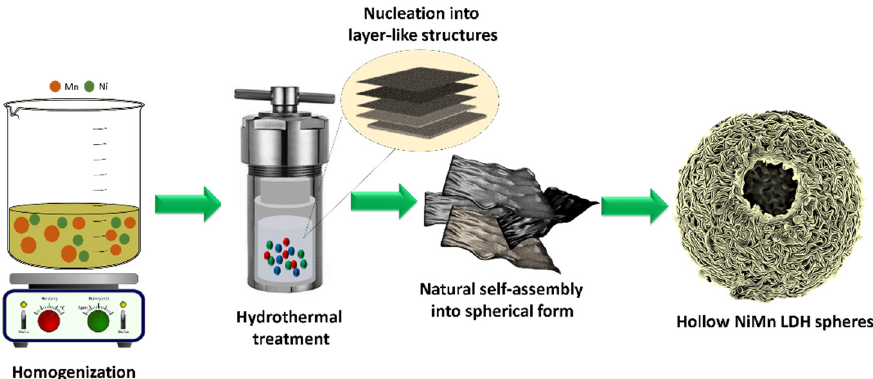
Figure 1. Schematic illustration of NiMn-LDH hollow sphere preparation by hydrothermal treatment.